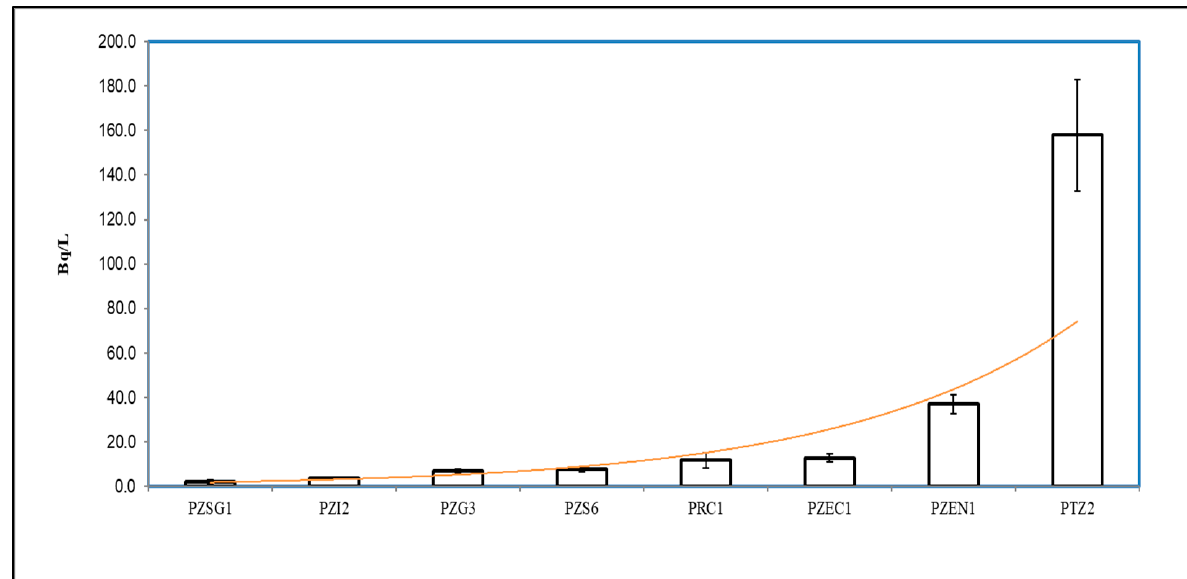
Figure 11. Graph of Radon Volumetric Activity Concentration in Monitored Piezometers (Median Values) [6].